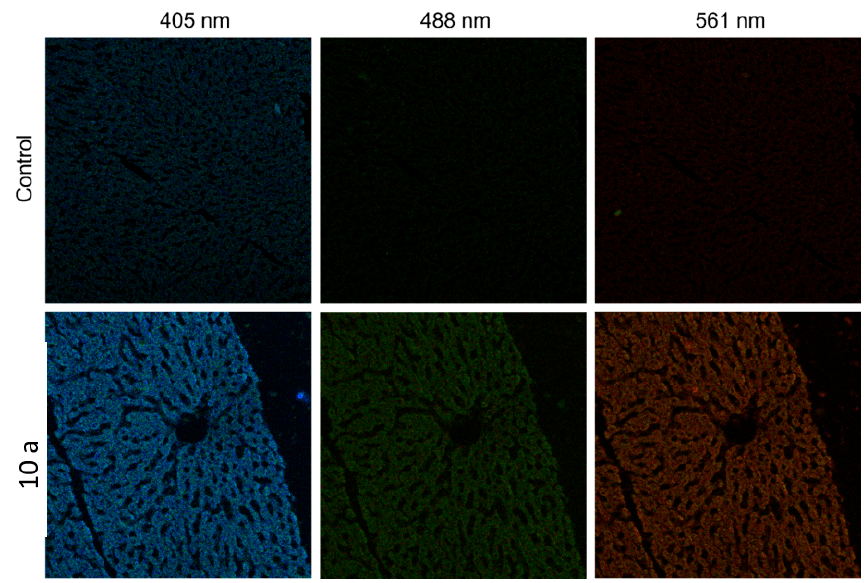
Figure 10. Image of rat liver sections unstained control sections ( top ) and stained with the Eu(III) complex 10a ( bottom ).